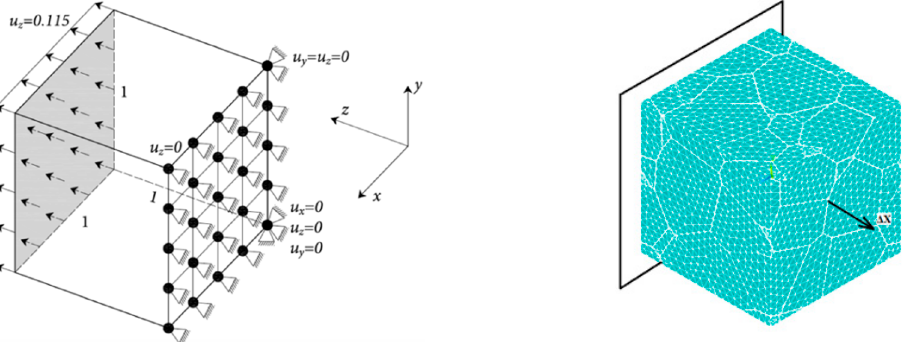
Figure 11. Applied boundary conditions (BCs) in the tensile numerical analysis.